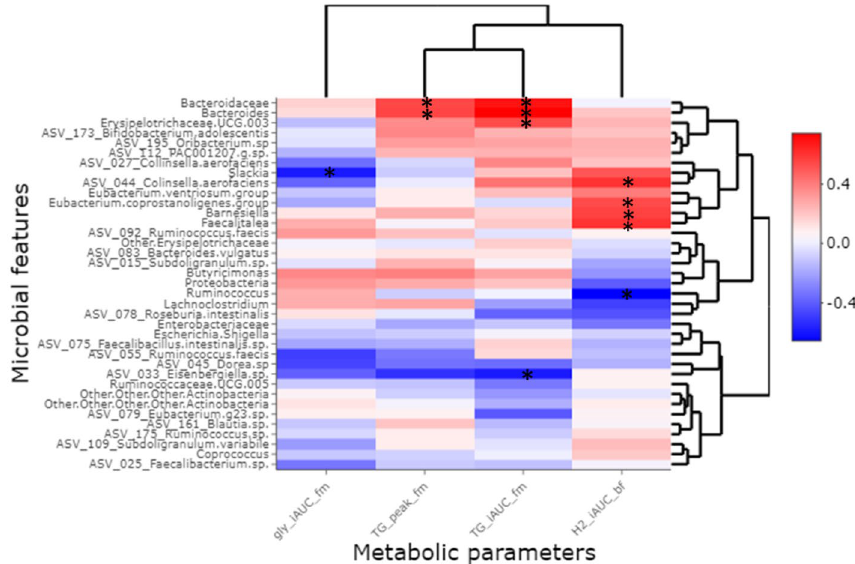
Figure 6. Correlations analyses between altered microbial features and metabolic parameters. The deltas (after–before) following CG supplementation for each metabolic parameter and microbial feature which were differently impacted by the two interventions (including those impacted in subgroup analysis) are presented. iAUC: incremental area under the curve; gly: glycemia; TG: triglyceridemia; H2: hydrogen; bf: